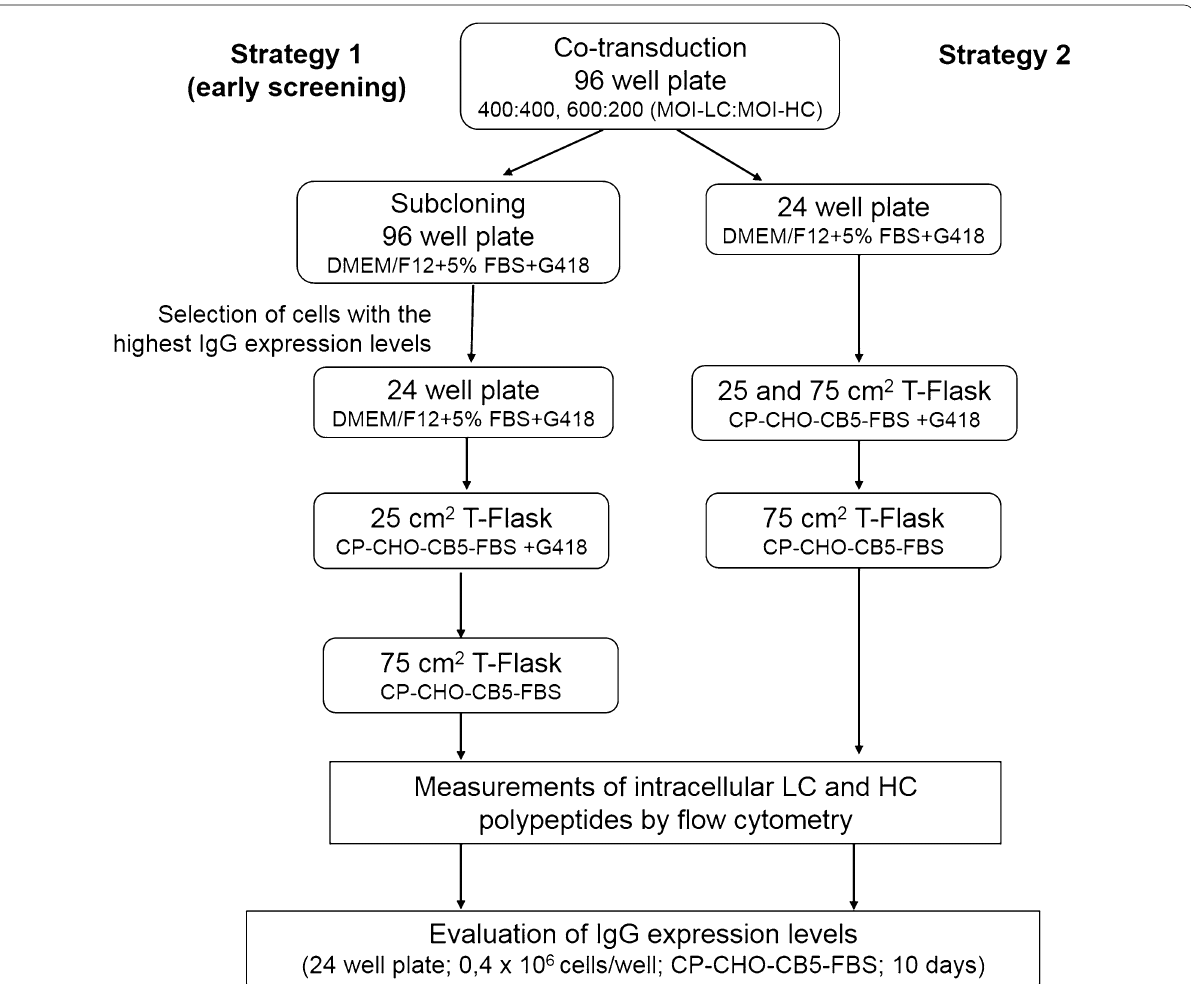
Fig. 2 Strategies for obtaining trastuzumab‑expressing CHO‑K1 cells. MOI: multiplicity of infection. FBS: fetal bovine serum. CP‑CHO‑CB5‑FBS: chemically defined, protein‑free medium CP‑CHO supplemented with 3 g/L of CB5 and 1% FBS. LC light chain, HC heavy